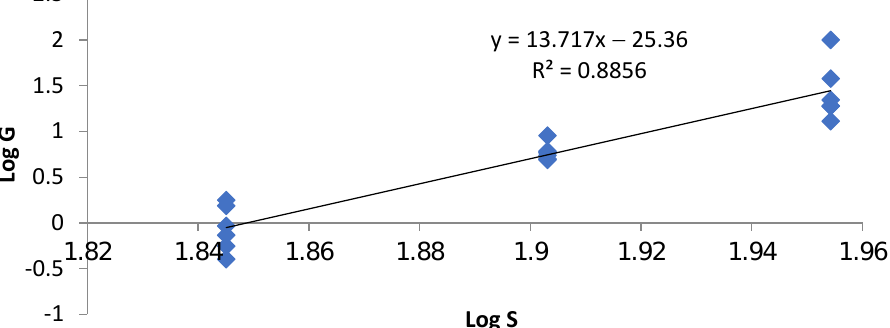
Figure 11. Correlation between the slopes of the sensors’ response baselines (G-value) and the corresponding stress levels (S) in fatigue tests.